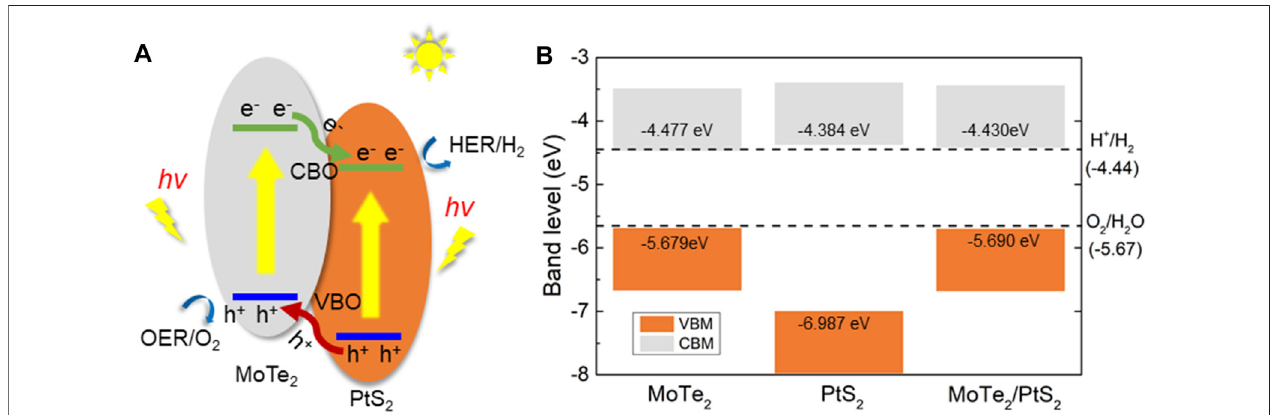
FIGURE 4 | (A) The photogenerated charges migration path and (B) the band alignment of the PtS 2 /MoTe 2 vdW heterostructure.